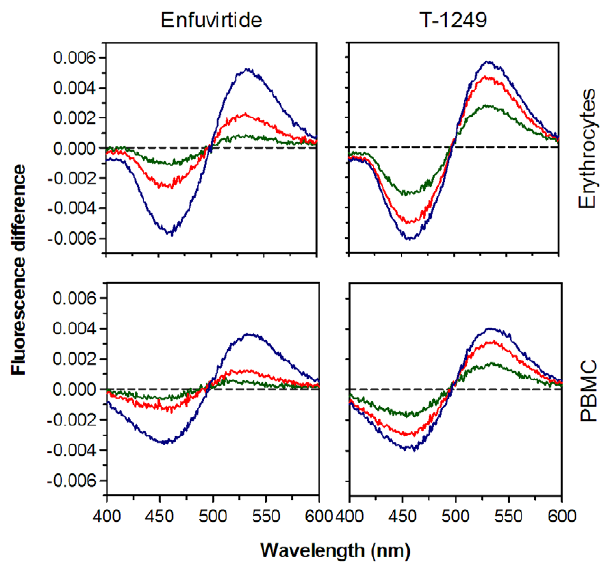
Figure 2. Differential spectra of membrane-bound di-8-AN- EPPS in the presence of HIV-1 fusion inhibitor peptides. The shape of the difference spectra reveal spectral shift to the red, indicative of a decrease in membrane dipole potential. For erythrocytes (top row) and PBMC (bottom row), the higher the peptide concentration (150 m M in blue, 40 m M in red and 10 m M in green), the higher the spectral shifts.